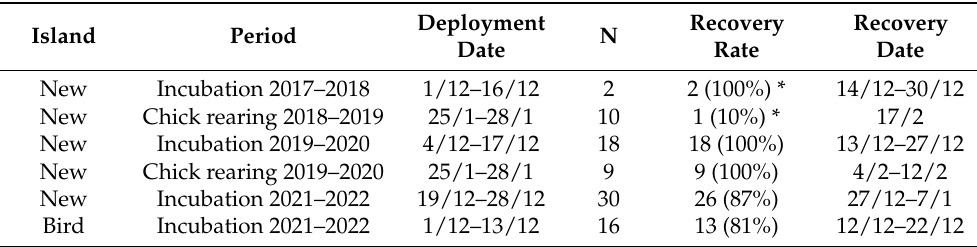
Table 1. Deployment and recovery periods, sample sizes (N) and recovery rates of Global Positioning System (GPS)-tracked Thin-billed